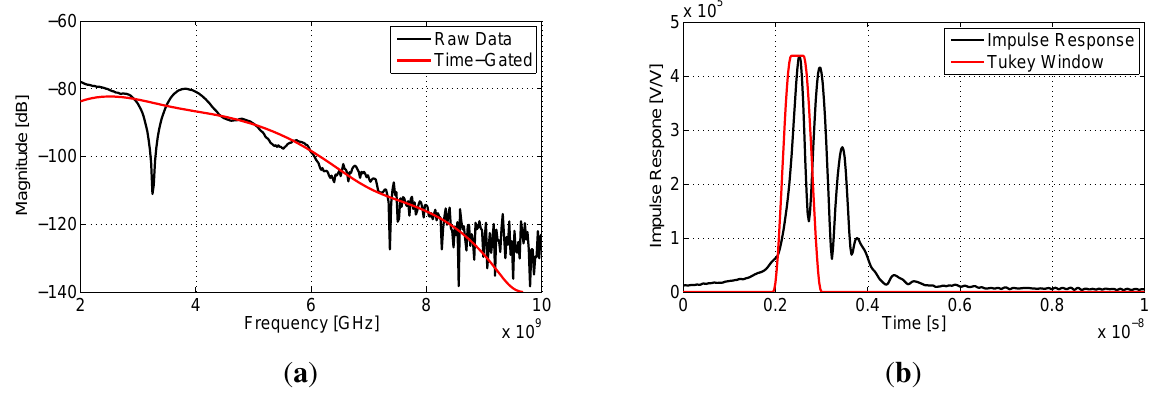
Figure 3. Transmission measurements collected from a patient and exhibiting strong multipath characteristics. ( a ) Frequency domain; ( b ) time